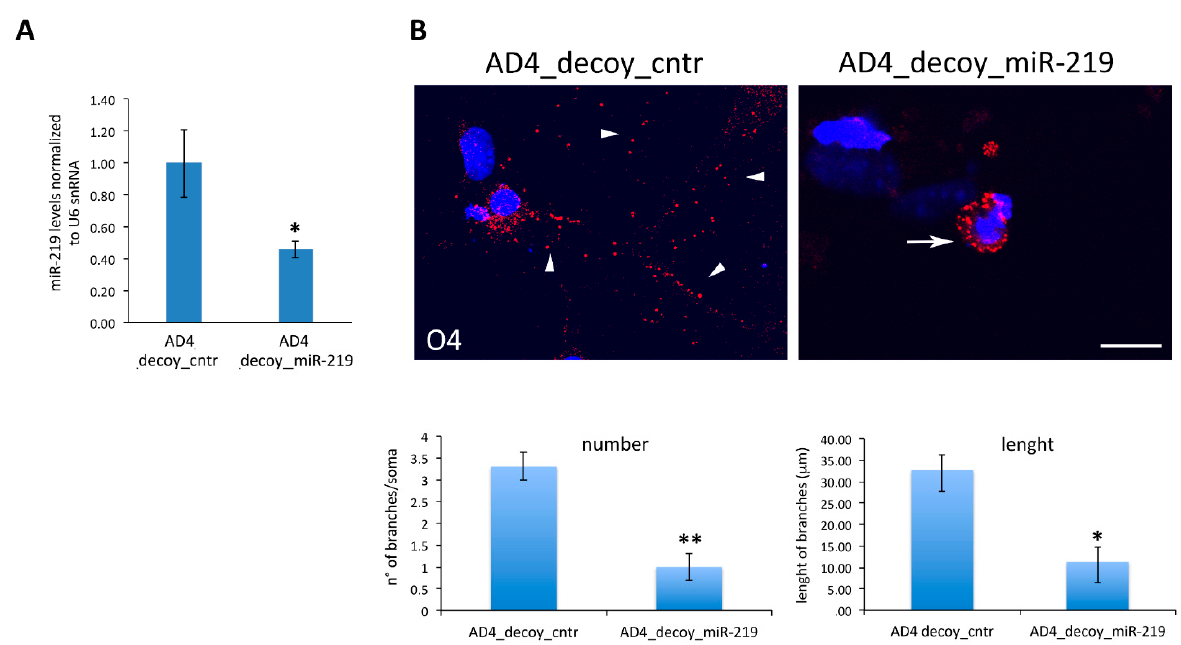
Figure 5. NGF neutralization promotes OLs differentiation through miR-219 modulation. ( A ): MiR-219 down-regulation in AD4 neurospheres upon transduction with a decoy_miR-219 lentivirus. qRT-PCR results are reported as the ratio between miR-219 levels in decoy_miR-219 versus decoy_miR_cntr infected AD4 cells. The results are expressed as the mean ± standard error (SEM) from five independent experiments ( n = 5). ( B ): Immunostaining for O4 (red) in AD4 progenitors infected with decoy_cntr or decoy_miR-219 lentiviruses. Inhibition of miR-219 in AD4 cells leads to poorly differentiated OL, without processes (arrow), compared to decoy_cntr infected cells (arrowheads), as quantified in the histograms (lower panel) ( n = 20 O4+ cells). Scale bar 10 µm, magnification 60×. The nuclei labeled with DAPI are in blue. Statistical significance is calculated relative to the AD4 decoy_cntr sample. Student’s t -test: * p < 0.05, ** p < 0.01.